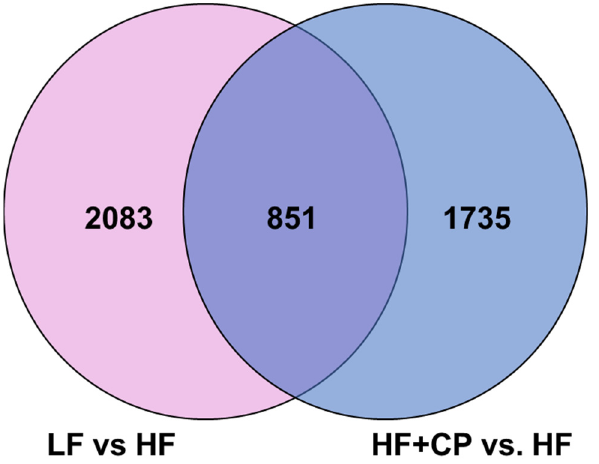
Figure 4. Venn diagram with gene expression of liver of male C57BL/6J mice fed either a LF diet or HF+CP.